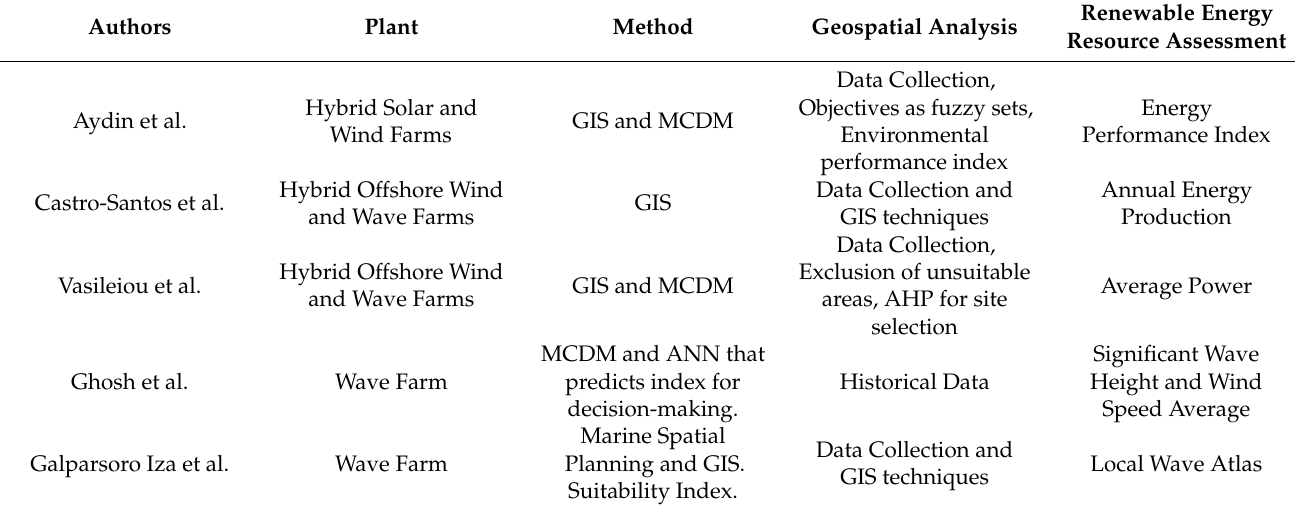
Table 2. Related work for WEC positioning assuming geospatial